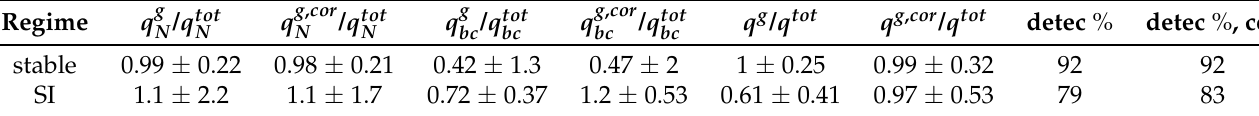
Table 1. Glider-based to total geostrophic PV ratio in the SYMPHONIE model with and without cross-stream correction considered for the front section shown in Figure 3. Numbers are given for the two most representative regions: stable and symmetrically unstable. Accurate detection of stability regimes (in percentage) are also given with reference ot the ones obtained using the total PV.